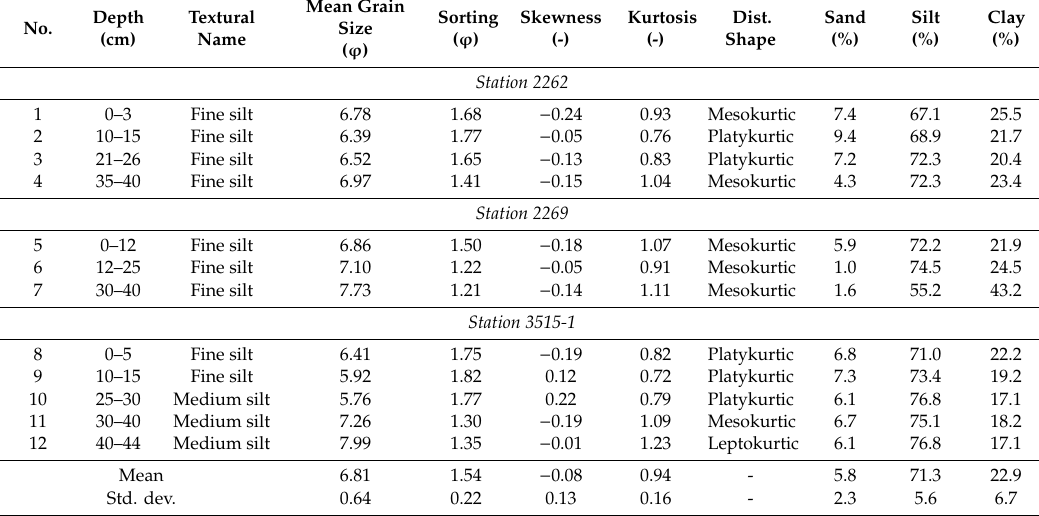
Table 5. The grain size data of analysed sediments ( n =